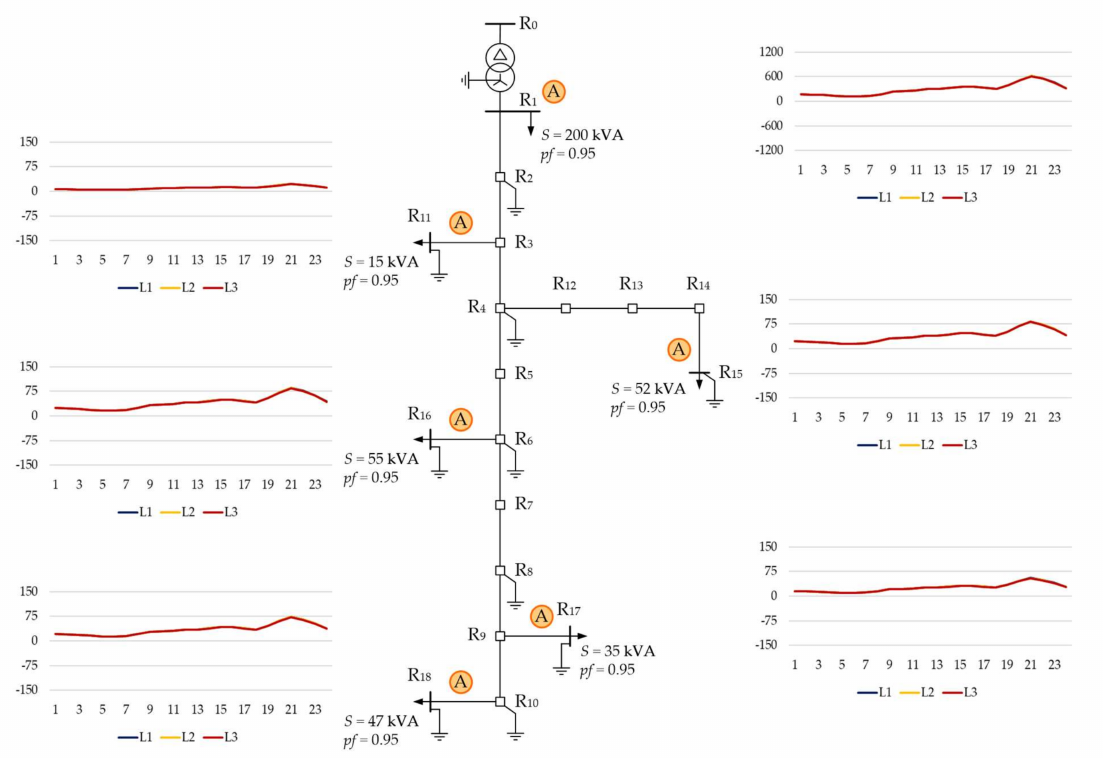
Figure 12. Daily simulation results showing the phase currents (A) in the test network for variant